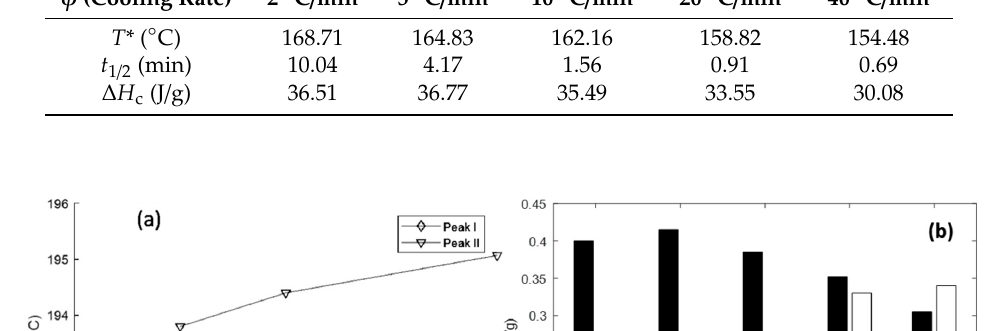
Figure 3. Peak positions and magnitude ratios for the non-isothermal crystallisation: ( a ) the evolution of peak centre temperature values, and ( b ) peak heights as a function of the cooling rate.